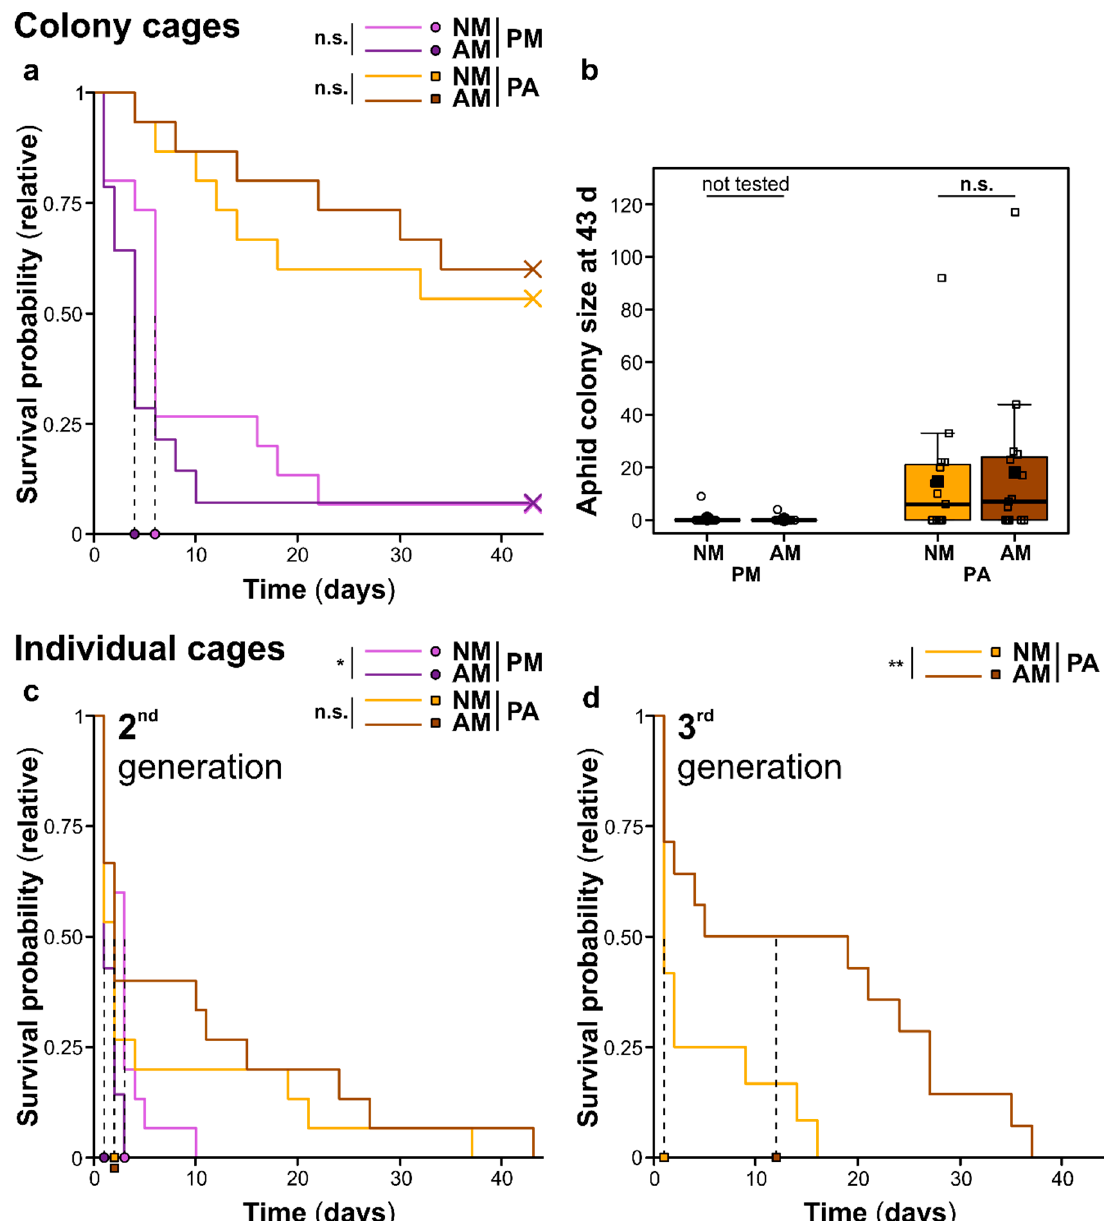
Figure 4. Performance of Myzus persicae aphids on Plantago major (PM) and Poa annua (PA) plants that have been left as controls (NM) or were inoculated with the arbuscular mycorrhizal fungus Rhizoglomus irregulare (AM) ( Experiment III , Aphid Performance ) in “colony cages” (first row) and in “individual cages” (second row). ( a , b ) Performance of aphid colonies, which started with five apterous adults each, i.e., ( a ) the survival of the colonies over time as Kaplan–Meier curves, with crosses indicating right censoring when the experiment was terminated and vertical dashed lines and symbols at the x axis indicating 50% survival, and ( b ) colony sizes 43 days after start of the aphid bioassay, as box-whisker plots with the medians given as horizontal thick lines, means as large filled symbols, interquartile ranges (IQR) as boxes, raw data points as small open symbols, and the whiskers extending to the most extreme data points within maximum 1.5 times the IQR; ( c , d ) Survival of individuals in the second ( c ) and third ( d ; for P. annua only) generation over time as Kaplan–Meier curves, with vertical dashed lines and symbols at the x axis indicating 50% survival. At the top of each subpanel, results of pairwise statistical tests ( a , c , d : log-rank tests; b : Mann–Whitney U -test) comparing NM and AM plants within species are given [n.s., not significant; *, p < 0.05; **, p < 0.01]. The sample sizes (biological replicates) were n = 14–15, except for the 3rd generation in the individual cages, where samples sizes were n = 12 (NM) and n = 14 (AM).